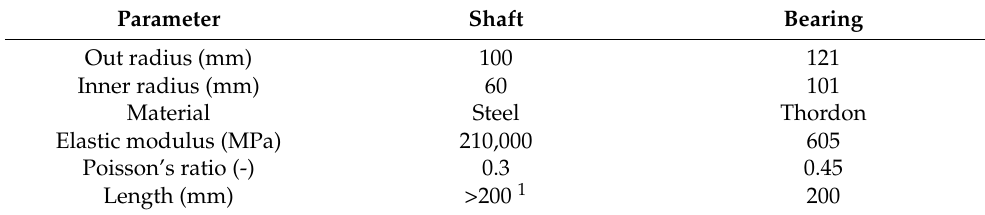
Table 1. Parameters of the shaft and bearing.